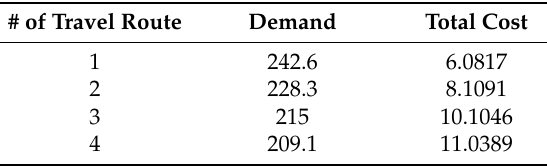
Table 3. The demand and total cost of each travel